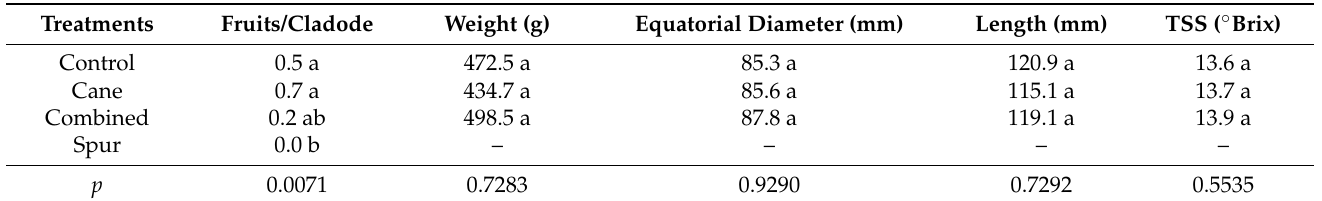
Table 3. Fruit production per cladode and fruit characteristics as an average in the first harvest in response to different pruning